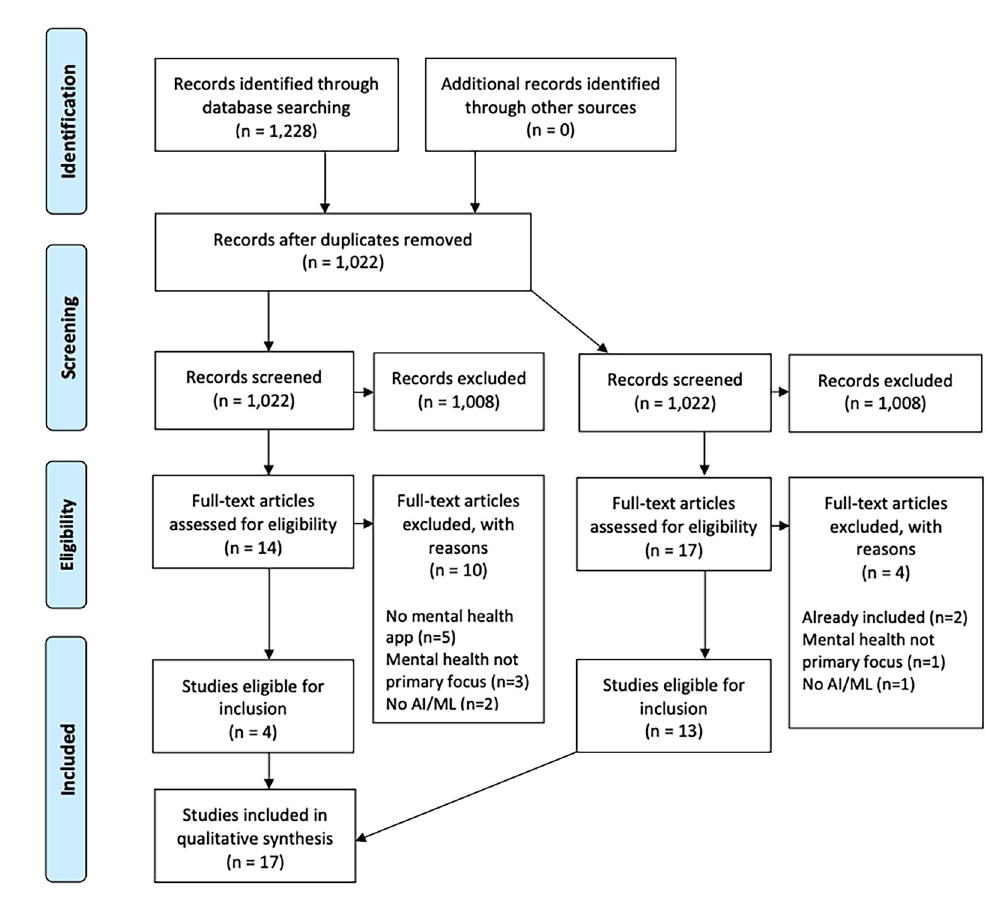
Fig 1. Preferred Reporting Items for Systematic Reviews and Meta-Analyses (PRISMA) flow